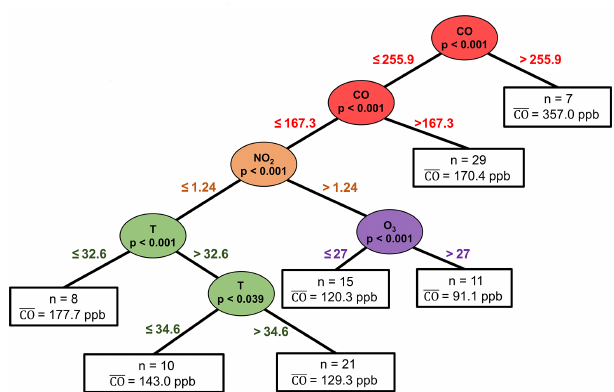
Figure 2. Simplified illustration of one potential CO random for- est tree for one RAMP monitor using 100 data points (the trees within the actual models are significantly more complex, and 500 such trees are included in the final models). Tree nodes are colored by splitting variable, and split point is overlaid on the branch (e.g., at first split, points with CO sensor signal > 255.9a.u. are sent to a terminal node; the remaining points go to the next splitting node). CO is the average CO reference monitor concentration (ppb) in each terminal node; n is the number of data points in each terminal